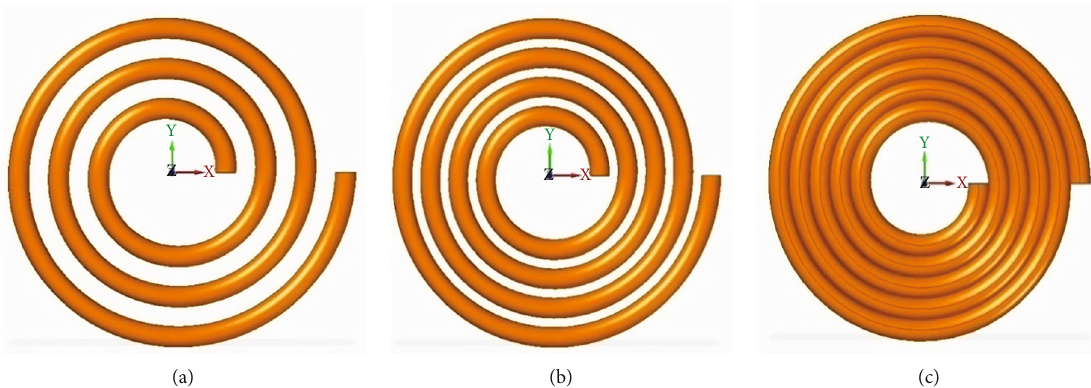
Figure 1: Spiral coil tubular copper absorber modeled on Solid Edge ST9 software as (a) 3 convolutions, (b) 4 convolutions, and (c) 5